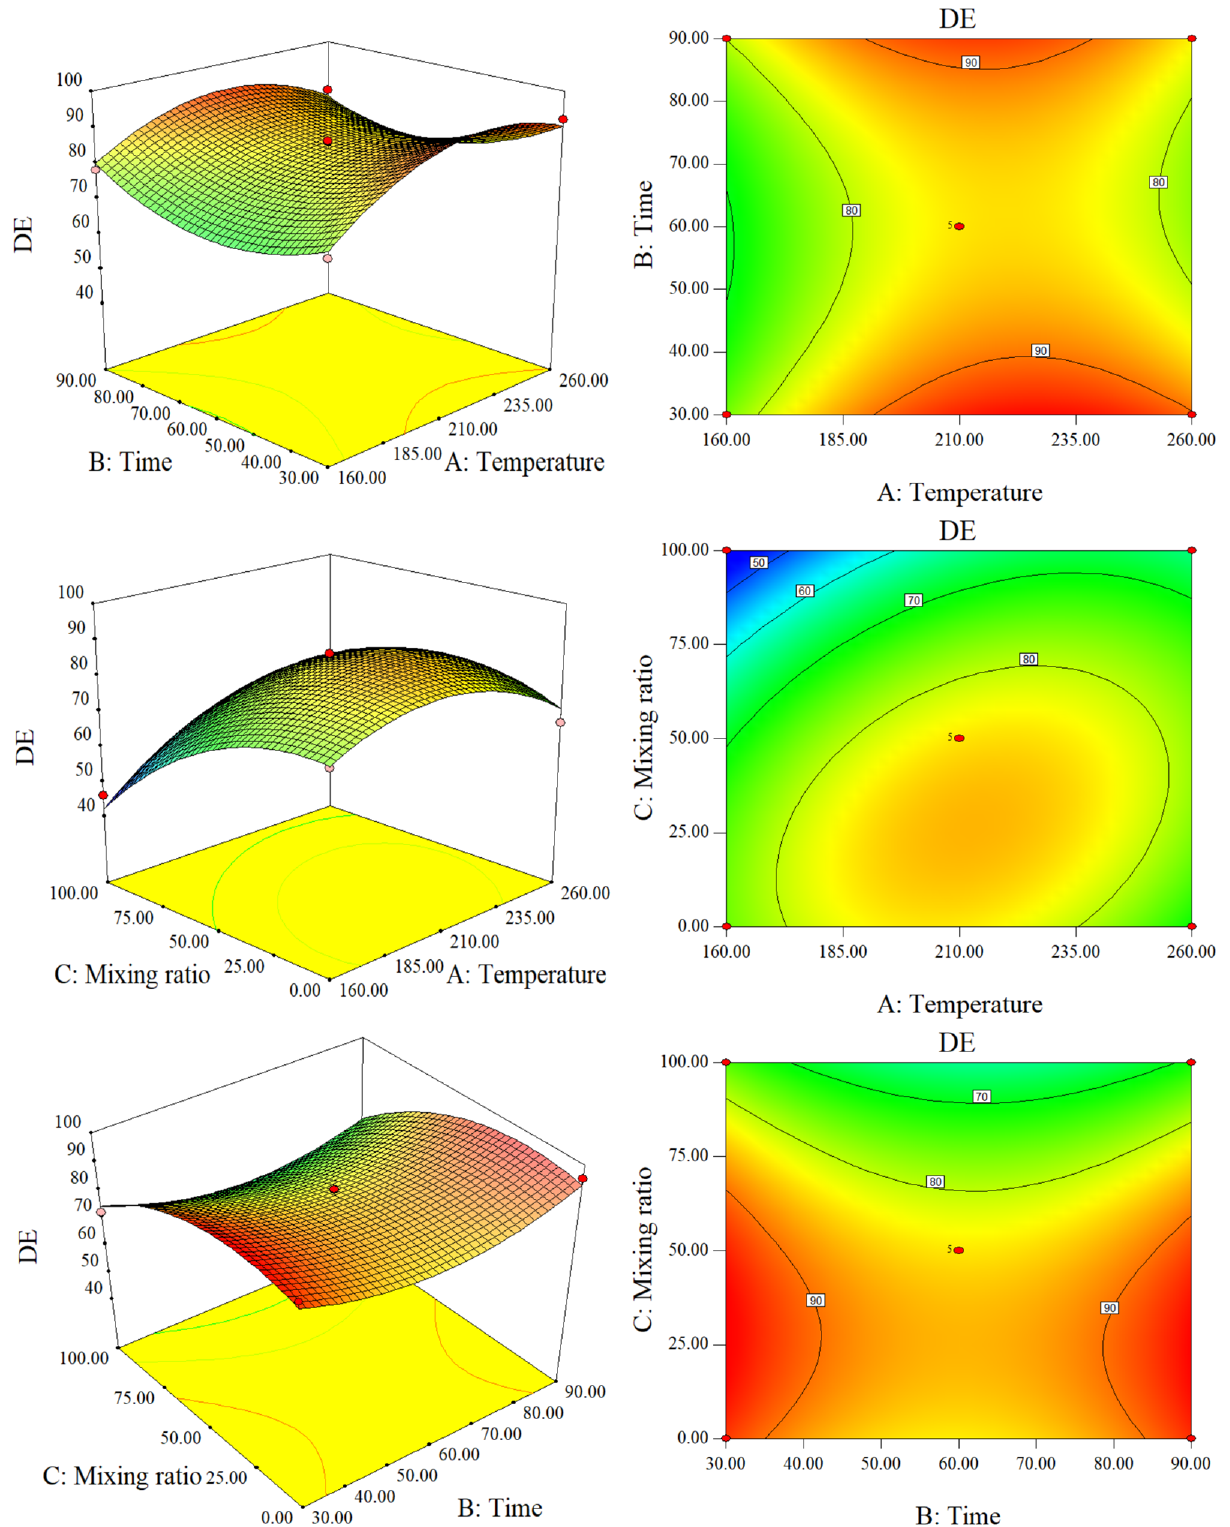
Figure 8. Response surface plots and contour plots of DE.